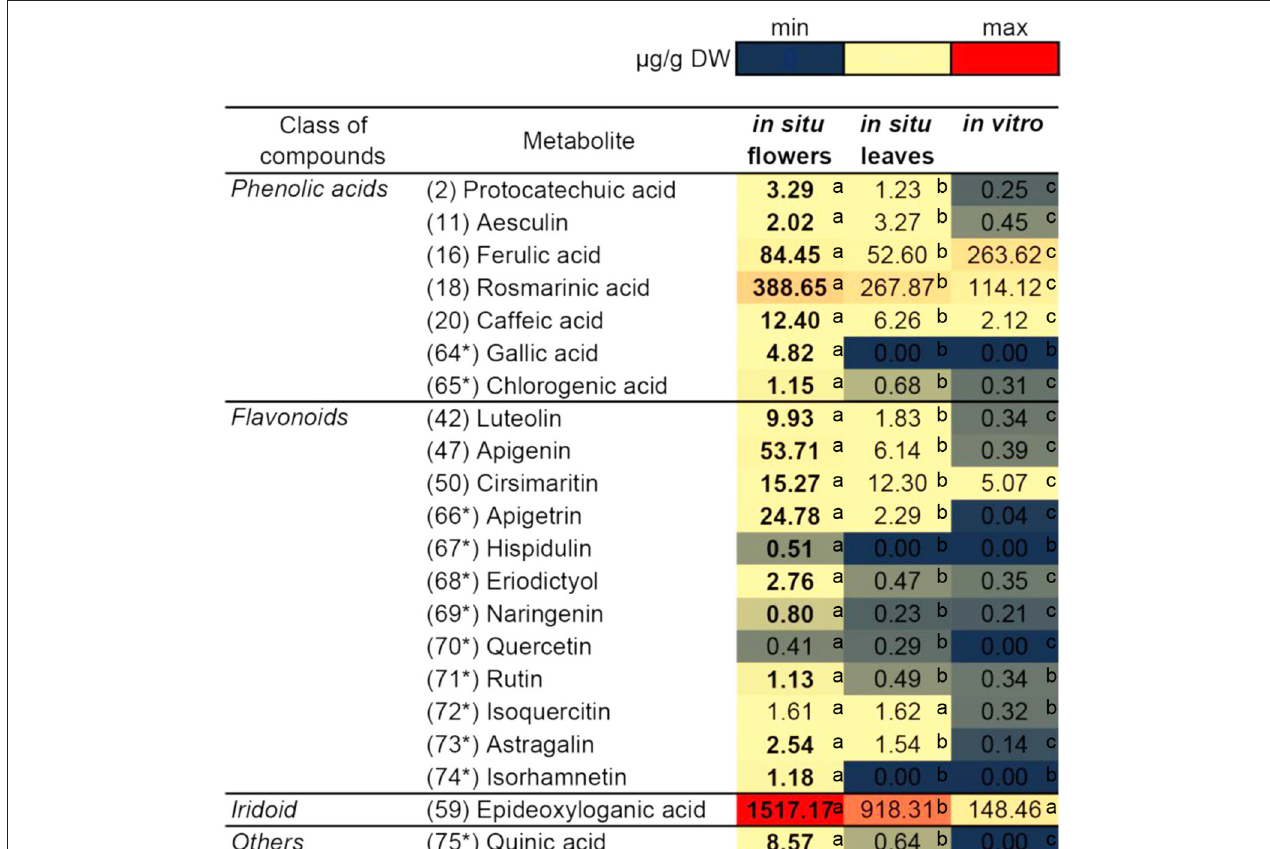
FIGURE 5 | Comparison of the quantity of major compounds among in situ flowers, in situ leaves and in vitro leaves of N. nuda by using UHPLC/MS2 analysis. Based on identified compounds in this work and additional phenolic-related compounds (labeled 64* to 75*), in total 21 compounds were selected for comparative quantification. Heat map visualization. One-way ANOVA (Holm–Sidak) test was applied to determine the statistical difference between the variants (shown in different letters).